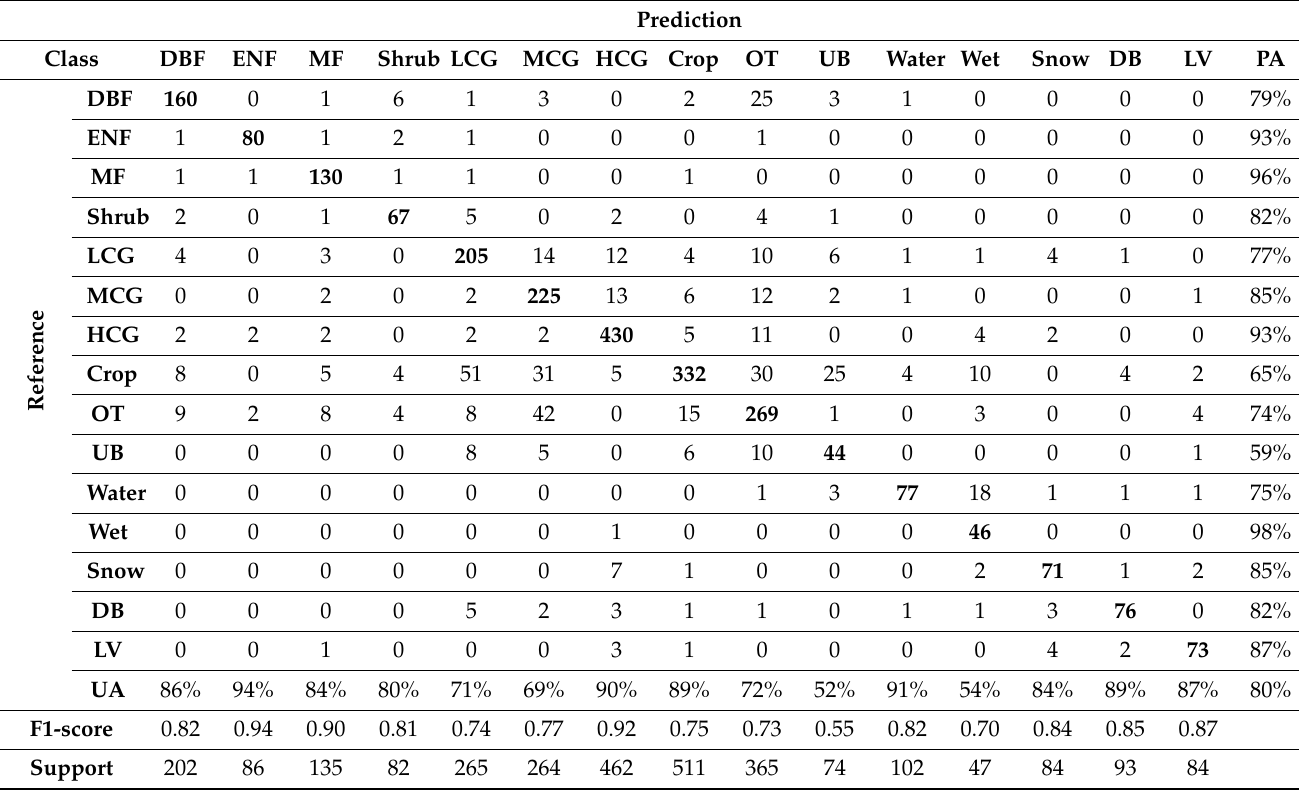
Table 3. Confusion matrix of 3456 independent stratified random sampling validation points set from 2001 to 2018. UA denotes user’s accuracy, PA denotes producer’s accuracy, F1-score is the weighted harmonic mean of PA and UA, and bold numbers represent correctly classified